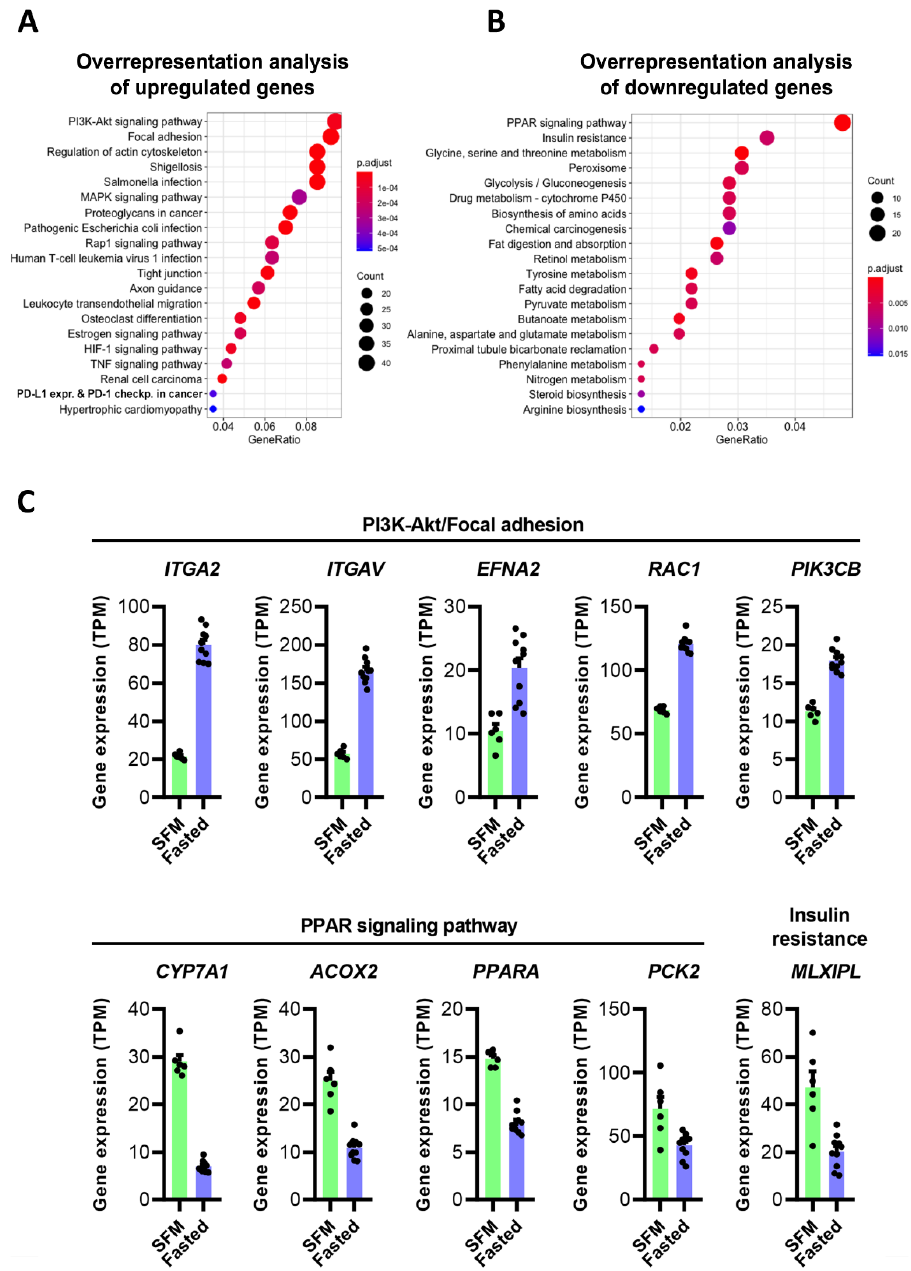
Figure 4. The gene expression in HepG2 cells exposed to human serum. ( A , B ) Overrepresentation analysis of upregulated or downregulated genes in cells incubated with serum from fasting participants, compared to cells in serum-free medium (>1.5-fold up- or downregulated, fdr < 0.05). ( C ) Upper panel : Selected genes in the PI3K-Akt and/or focal adhesion pathway that were upregulated in cells incubated with human serum. Lower panel : Selected genes in the PPAR signalling or insulin resistance pathways that were downregulated in cells incubated with human serum. Gene expression values are displayed as TPM (mean ± SEM). SFM: serum-free medium.